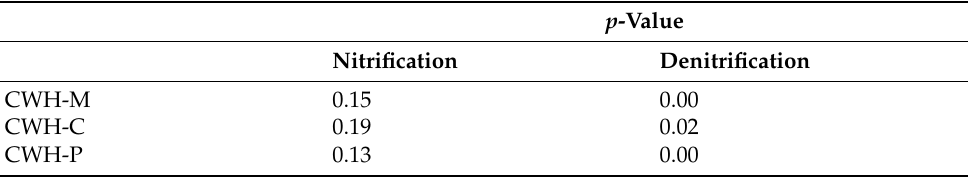
Table A4. p -values obtained from t -test